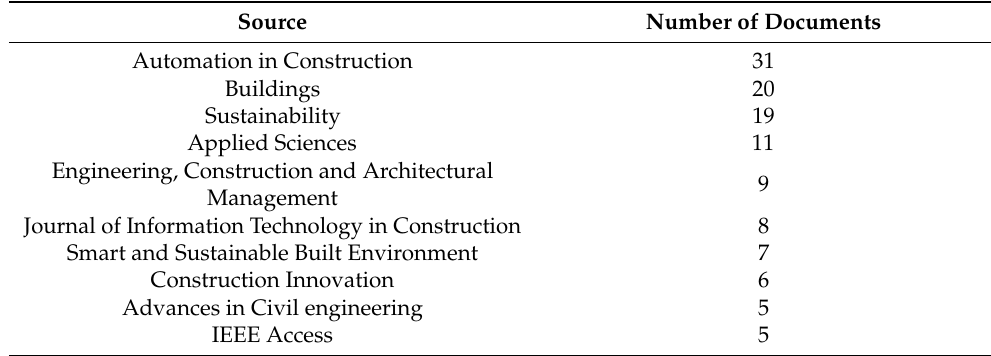
Table 8. Most relevant